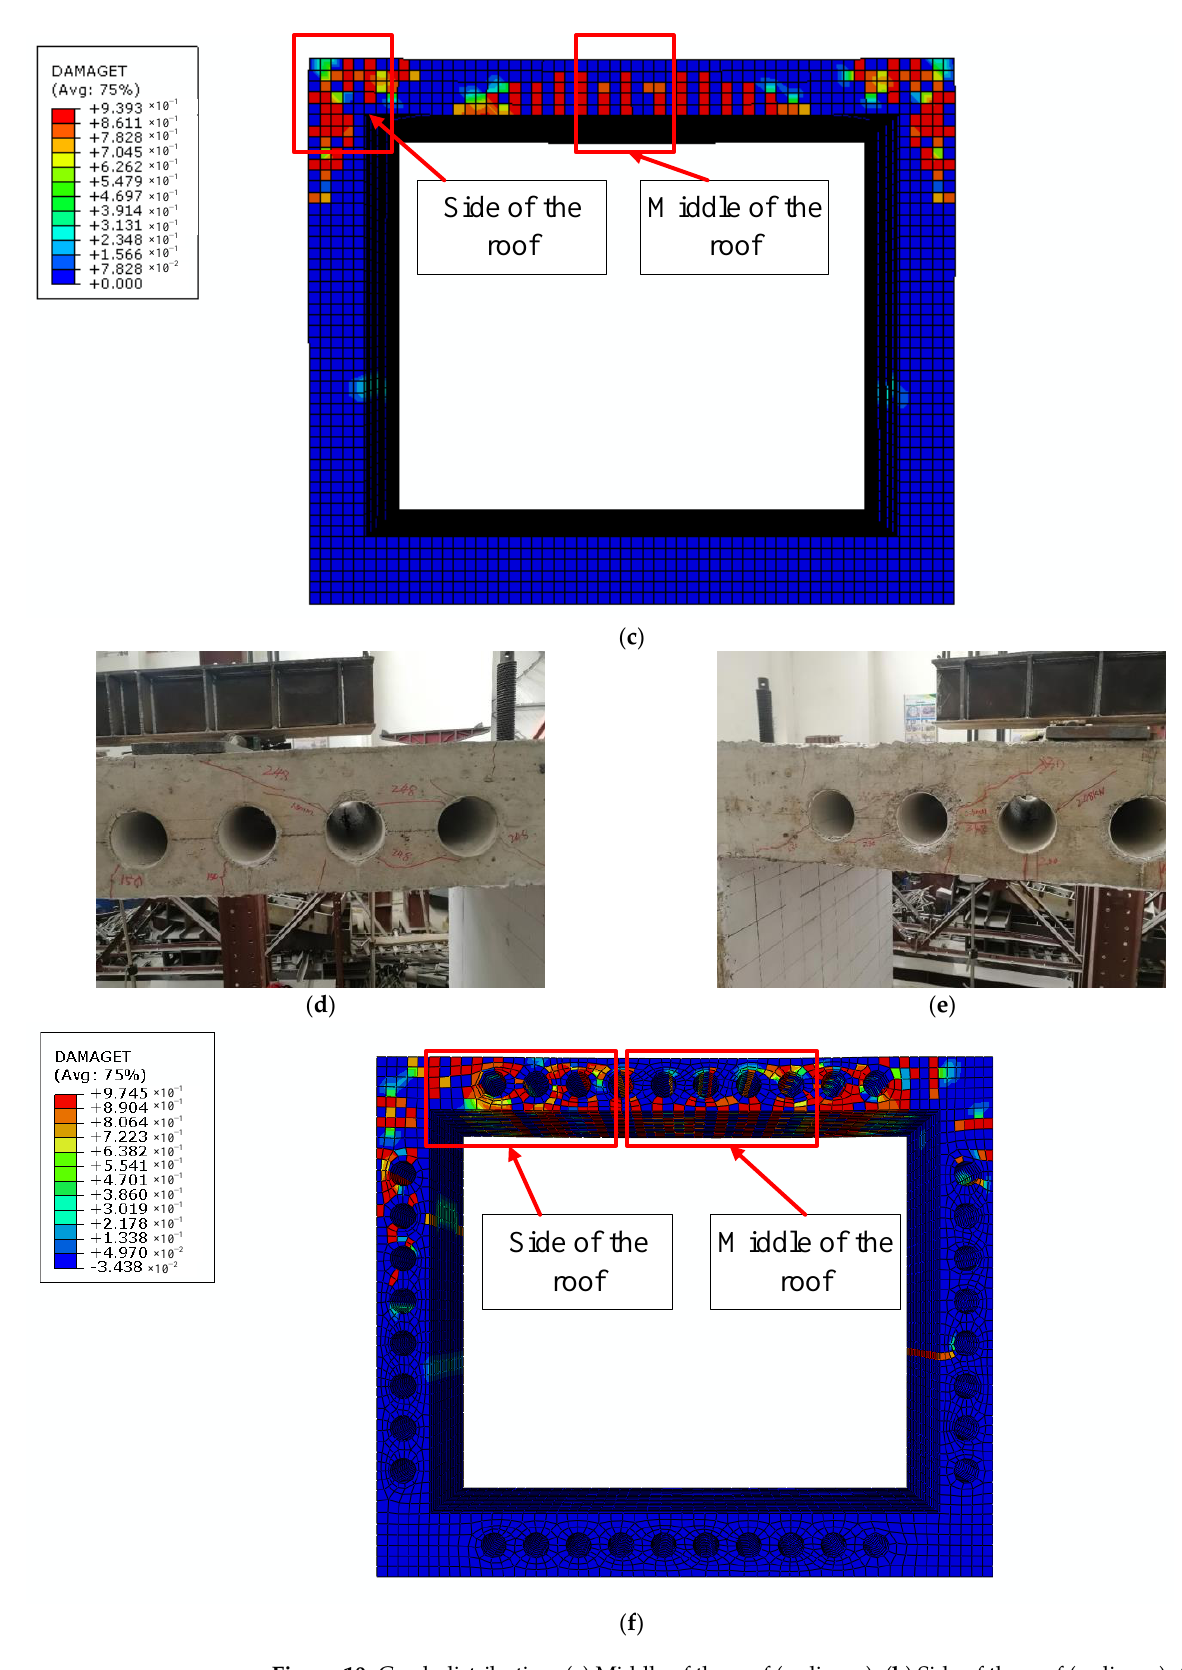
Figure 10. Crack distribution. ( a ) Middle of the roof (ordinary). ( b ) Side of the roof (ordinary). ( c ) FEM result (ordinary). ( d ) Middle of the roof (hollow). ( e ) Side of the roof (hollow). ( f ) FEM result